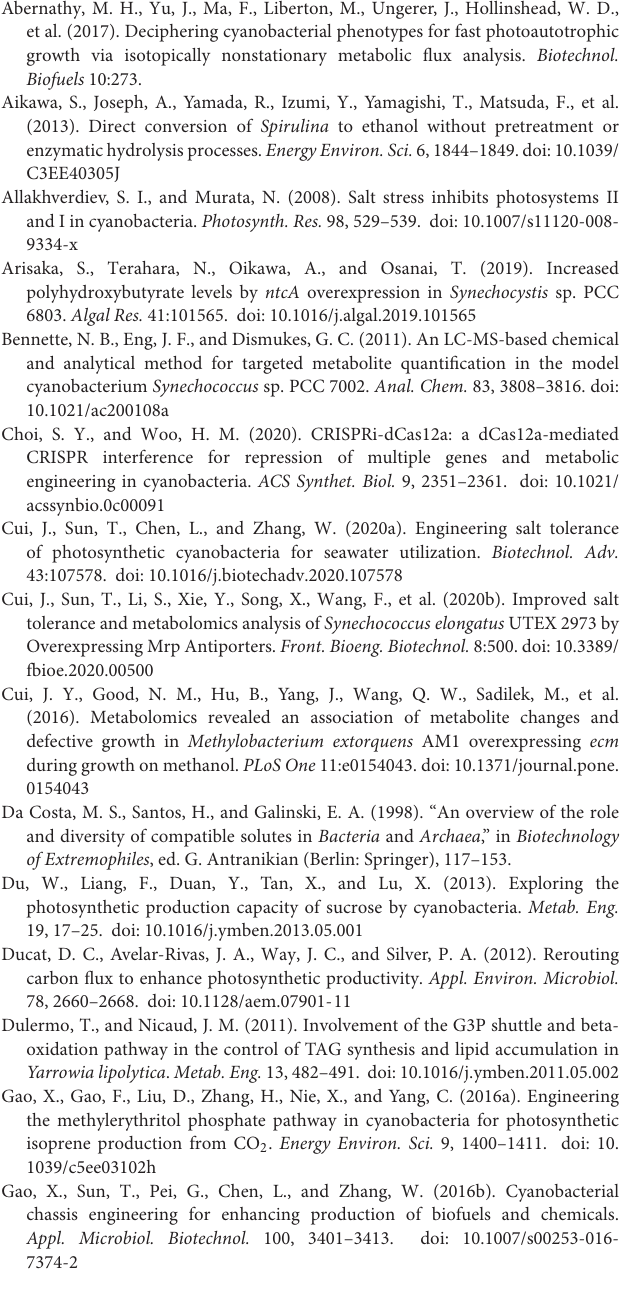
Supplementary Figure 5 | Transcript level measurements of pgl , glgA , and rfbA in strains M-2522-GgpPS-dpgl, M-2522-GgpPS-dglgA, and M-2522-GgpPS-drfbA (orange) and the control strain M-2522-GgpPS-pSII (blue) using qRT-PCR. Supplementary Figure 6 | Growth curves of strains under salt and high light (500 µ mol photons m − 2 s − 1 ) stress conditions. Supplementary Table 1 | Primers used in this study. Supplementary Table 2 | The raw metabolomics data of the